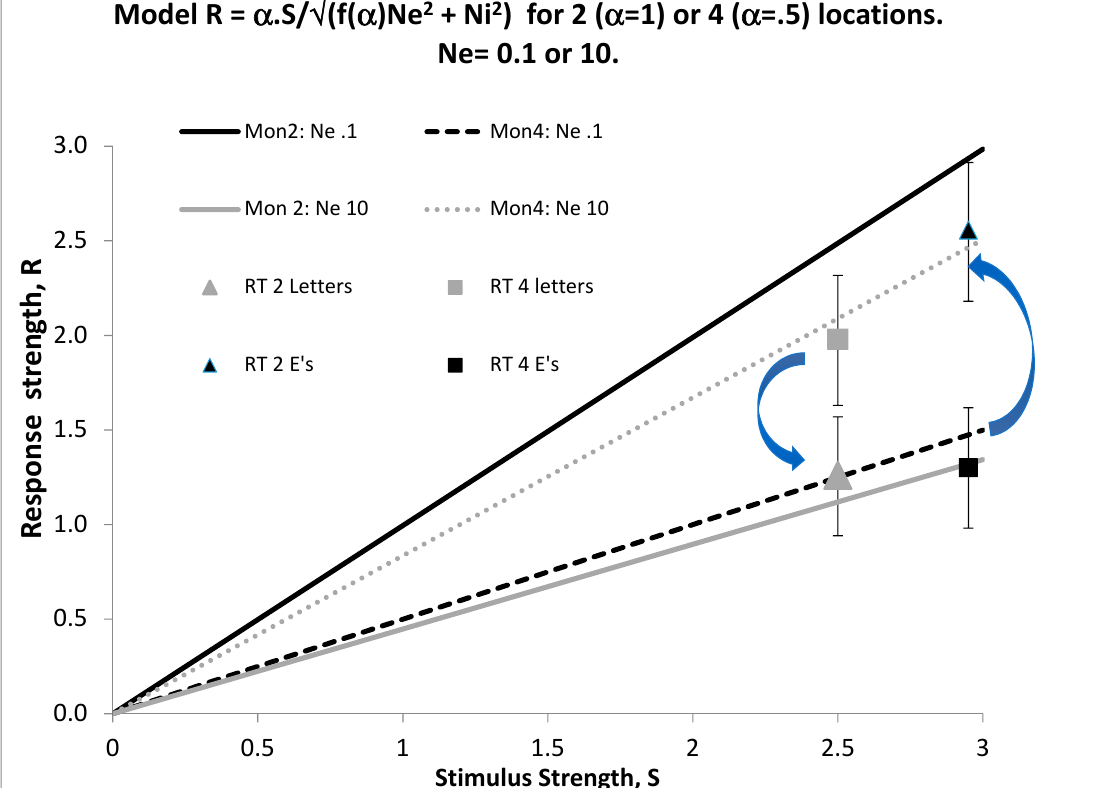
Figure 1. Stimulus (S) and response (R), assuming linear transduction for S and constant internal noise (Ni = 1.0). The response is in units of d’. Arrows indicate that focusing improves the response when Ne = 0.1 (black lines) but hurts when Ne = 10 (grey lines). The lines illustrate that focusing can have opposite effects depending on the level of external noise (see text). Data from [6] (Fine and Reeves, 2018) confirm this pattern for specific levels of S. However we did not vary S parametrically, so the form of the transduction is unknown. Squares (RTs in Mon 4) and triangles (RTs in Mon 2) plot latency data converted to rates according to Equation (2) with b = 0.17 and RTo = 0.40 s; grey symbols for letters, black symbols for Es. Bars show +- one standard error around each rate. One wonders why Ne, or more precisely, Ne/Ni, varied so much between optotypes and letters. Endogenous attention acts as a gate in the model of Reeves and Sperling [24]. If the gate must be held open for longer to identify individual letters than to detect the orientation of the Es, external noise from the placeholders (acting as masks) will be greater in the former than the latter task. That is, holding the gate open for long enough to obtain sufficient information to identify arbitrary letters lets in so much noise from the placeholders that focusing becomes deleterious. An experiment in which the placeholders did not return, so that only forward masking occurred, could test this notion; whereas patterned backward masks limit processing time, forward masks do not [23,27]. If, instead, gating was fixed and Ne was constant, the internal noise (Ni) associated with the Es would have to differ markedly from that for the other letters; given that the Es and other letters shared the same locations in spatial frequency and in space, this seems less plausible. A further question, raised by a reviewer, is whether feature-based attention, as well as the spatial attention discussed here, may also suffer from focusing. As presented, the model does not distinguish between the two, and so it would imply that, if attention to featural noise exceeded attention to the target features, performance would suffer.